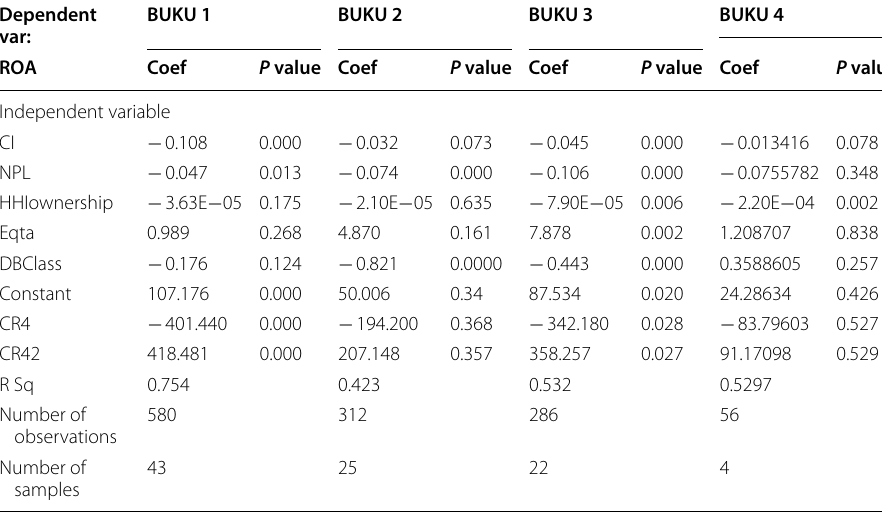
Table 7 Regression result for CR4 and profitability relationship for each BUKU. Source: Author’s calculation on data provided by the Indonesia Financial Services Authority